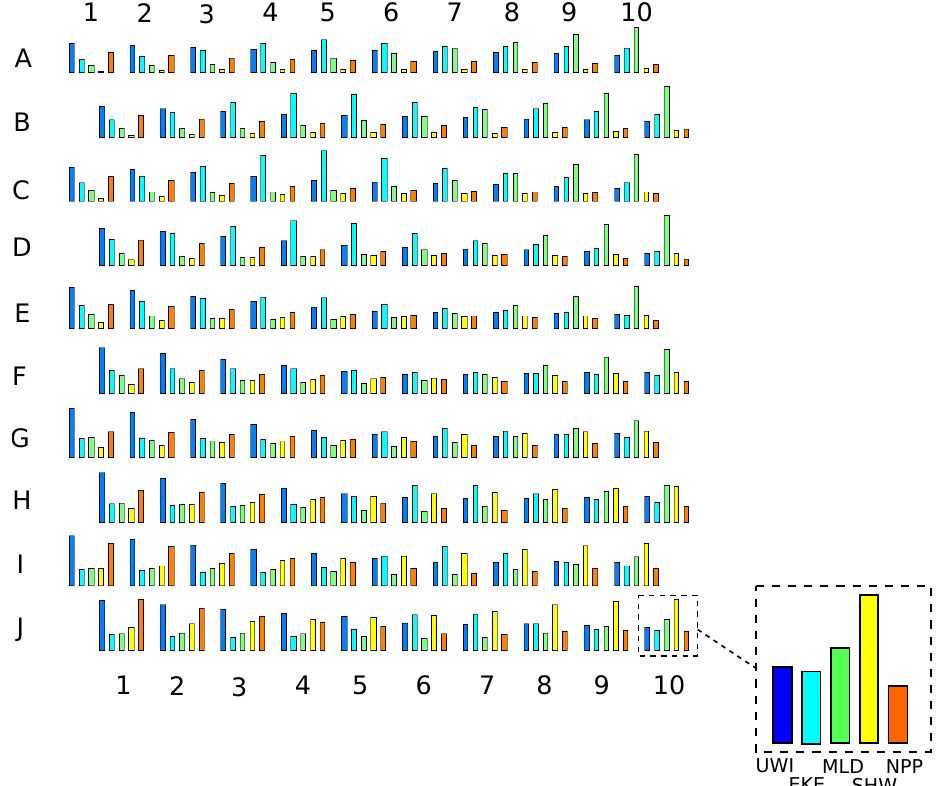
Fig. 3. Visualization of EBUS production patterns on the SOM. Each neuron corresponds to a prototype of production regime defined by a given combination of NPP and the 4 drivers. For comparison between different variables, data is normalized between 0 and 1.